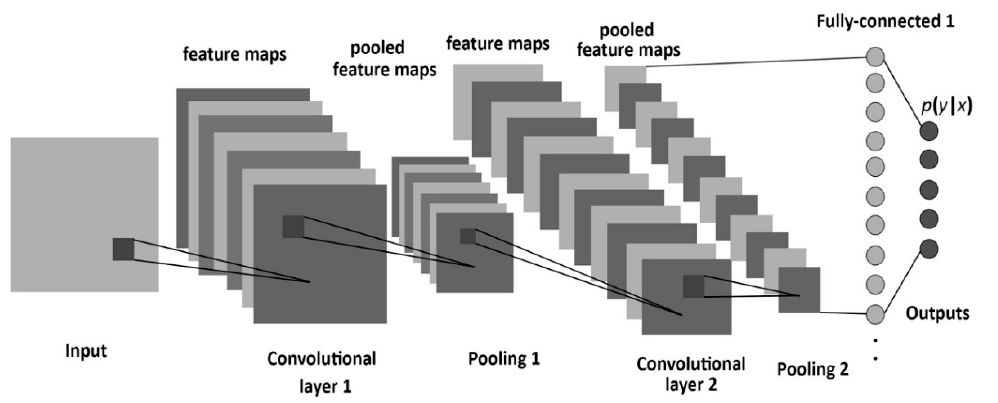
Figure 6. The basic CNN model architecture [43,45].